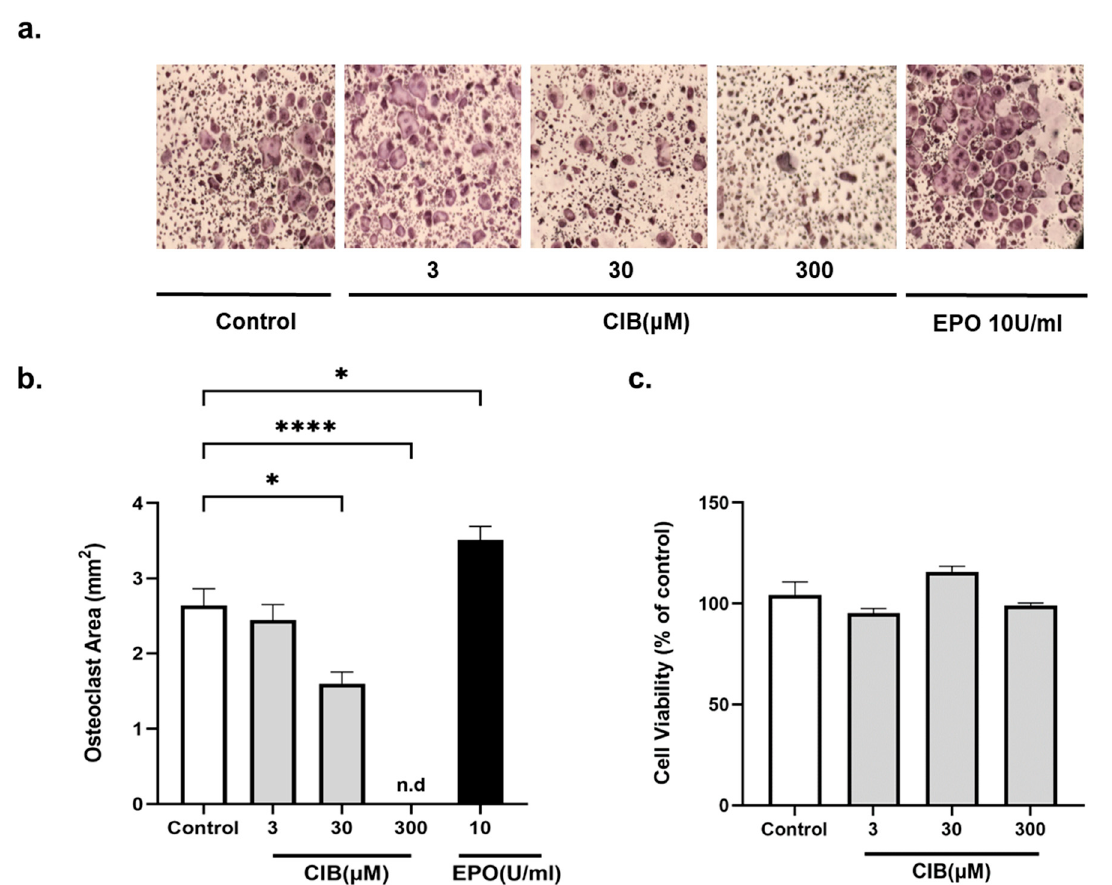
Figure 1. Cibinetide (CIB) attenuates osteoclast differentiation in vitro. BMDM were treated with Cibinetide in the presence of RANKL (50 ng/mL) and M-CSF (20 ng/mL). TRAP staining (images and TRAP + area) of osteoclasts are shown at the end of differentiation (4–5 days). ( a ) Representative micrographs of TRAP + osteoclasts. Original magnification at 2×. ( b ) Quantification of the total area of TRAP + multinucleated cells. ( c ) BMDMs were cultured in the presence of different concentrations of Cibinetide (3, 30, 300 μ M). After 48 h, MTT reagent was added to each well and the absorbance was measured at 560 nm. Data from at least three independent experiments are shown as mean ± SEM. * p < 0.05, **** p < 0.0001.